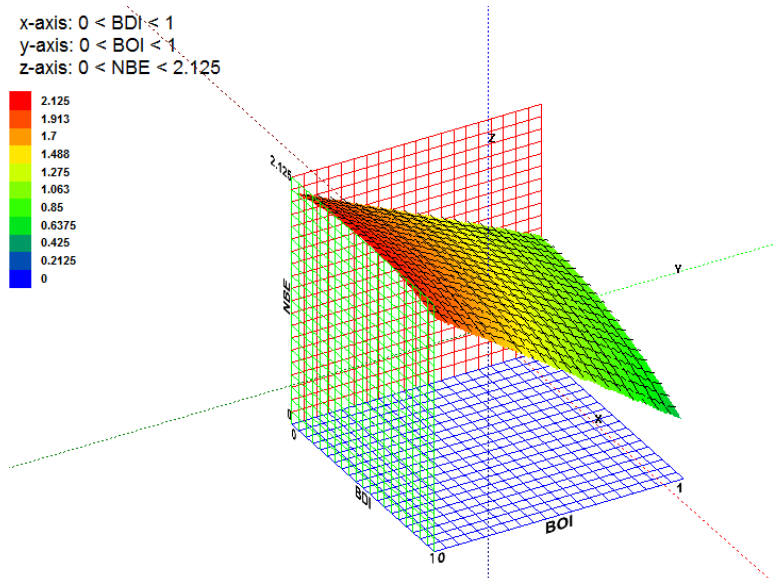
Figure 4. Normalized Building Energy surface plot.